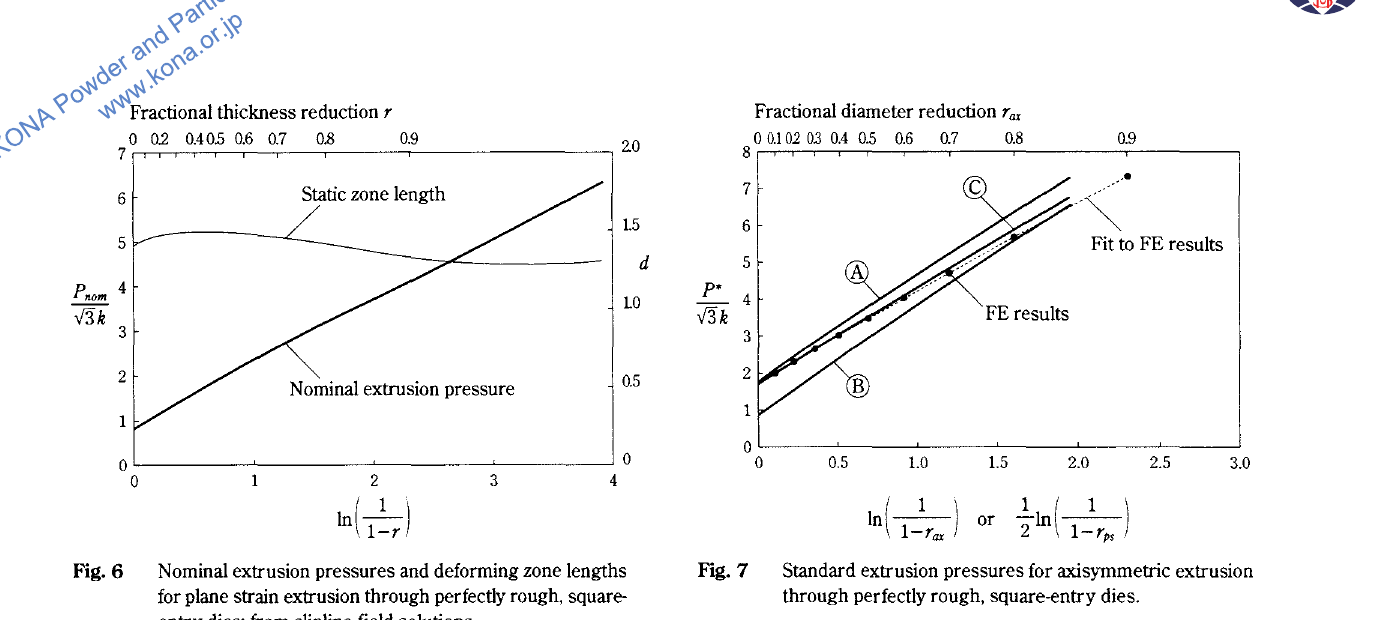
Fig. 7 Standard extrusion pressures for axisymmetric extrusion through perfectly rough, square-entry